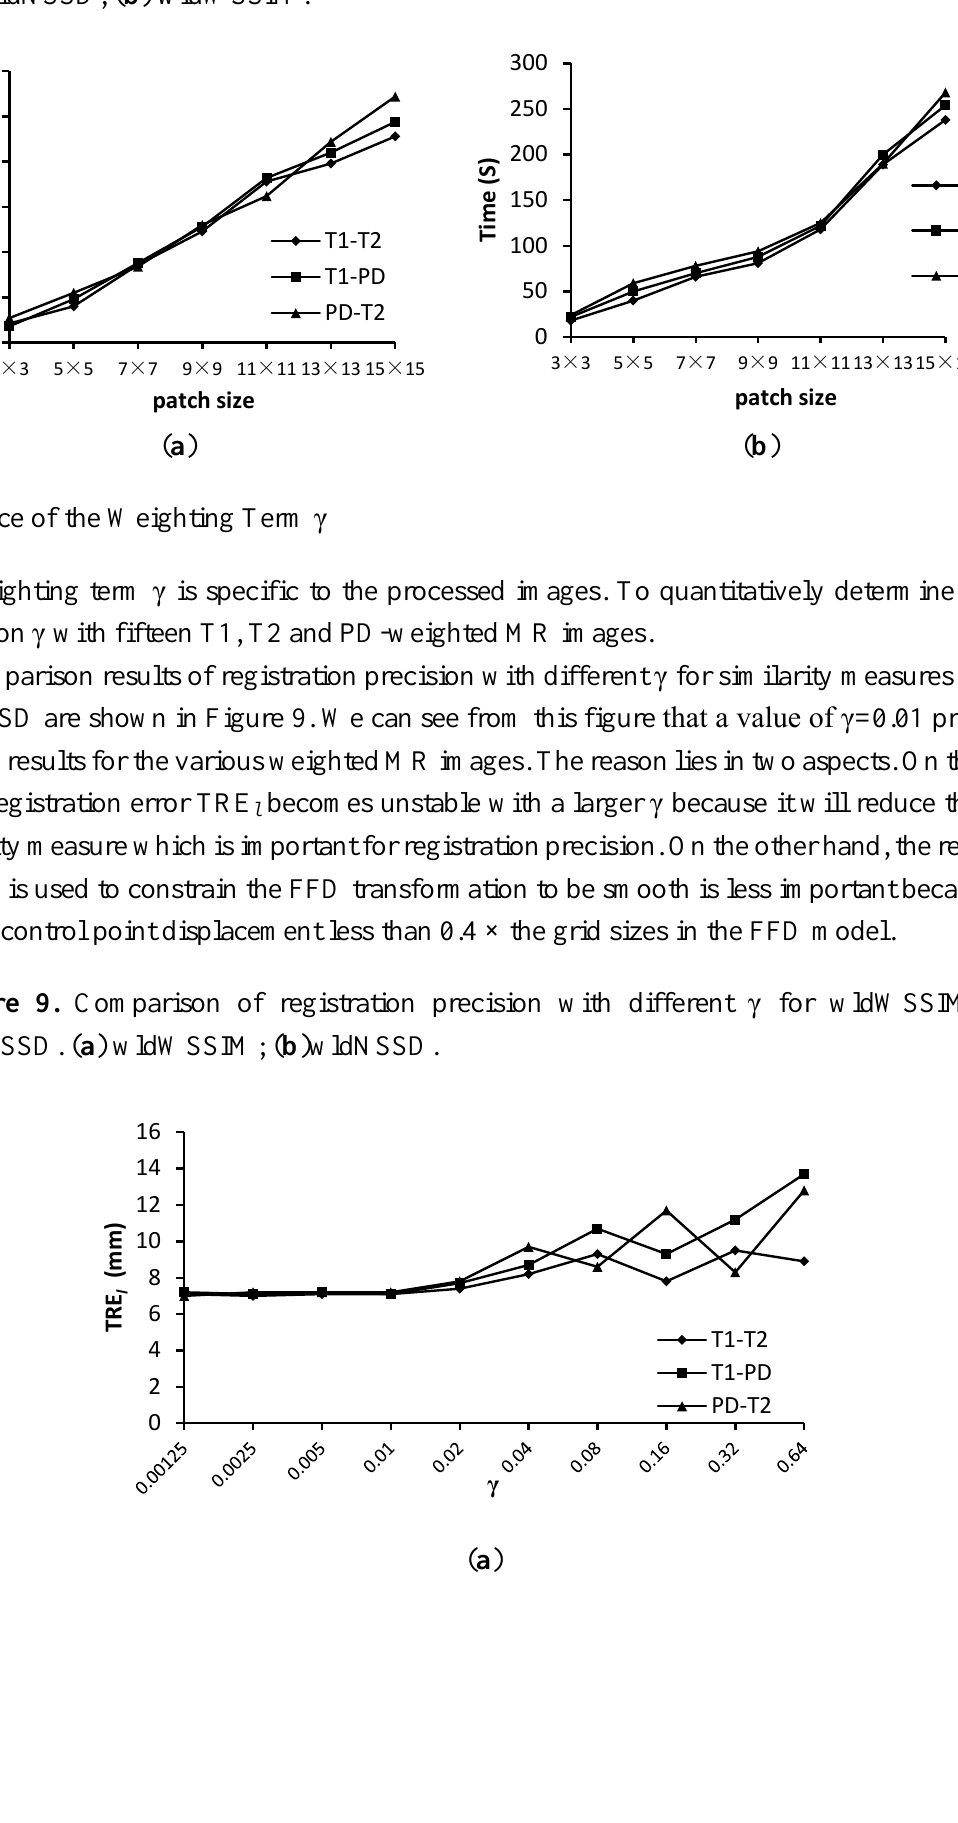
Figure 8. Time (in seconds) for the wldNSSD and wldWSSIM using various patch sizes. ( a ) wldNSSD; ( b ) wldWSSIM.